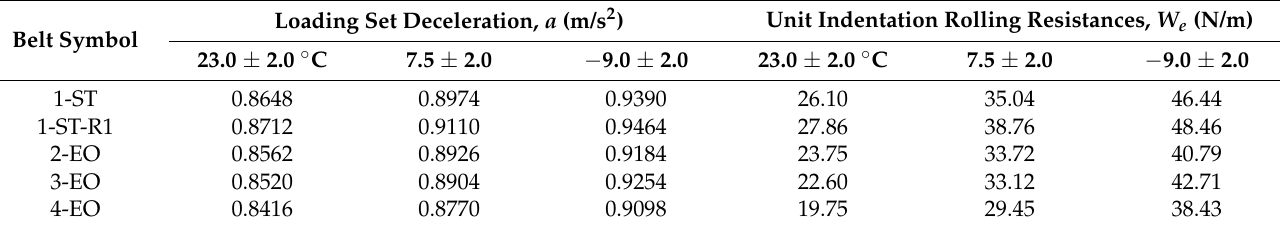
Table 5. Indentation rolling resistance test results at the investigated temperatures. Loading Set Deceleration, a (m/s 2 Belt Symbol